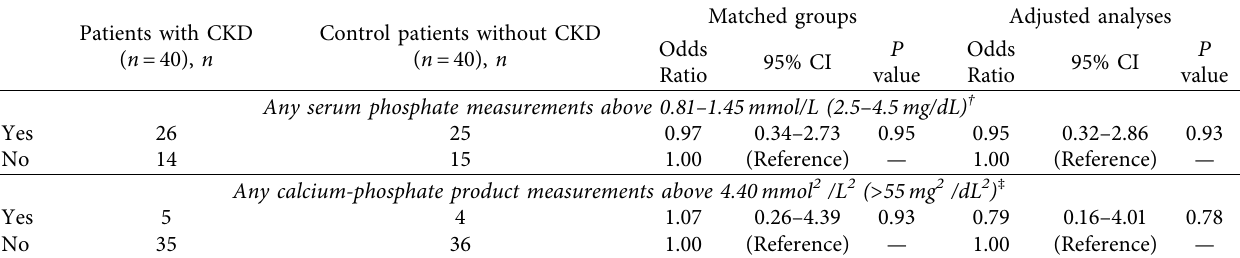
Table 3: Association between serum phosphate and calcium-phosphate product and development of CKD ∗ . Patients with CKD ( n � 40),